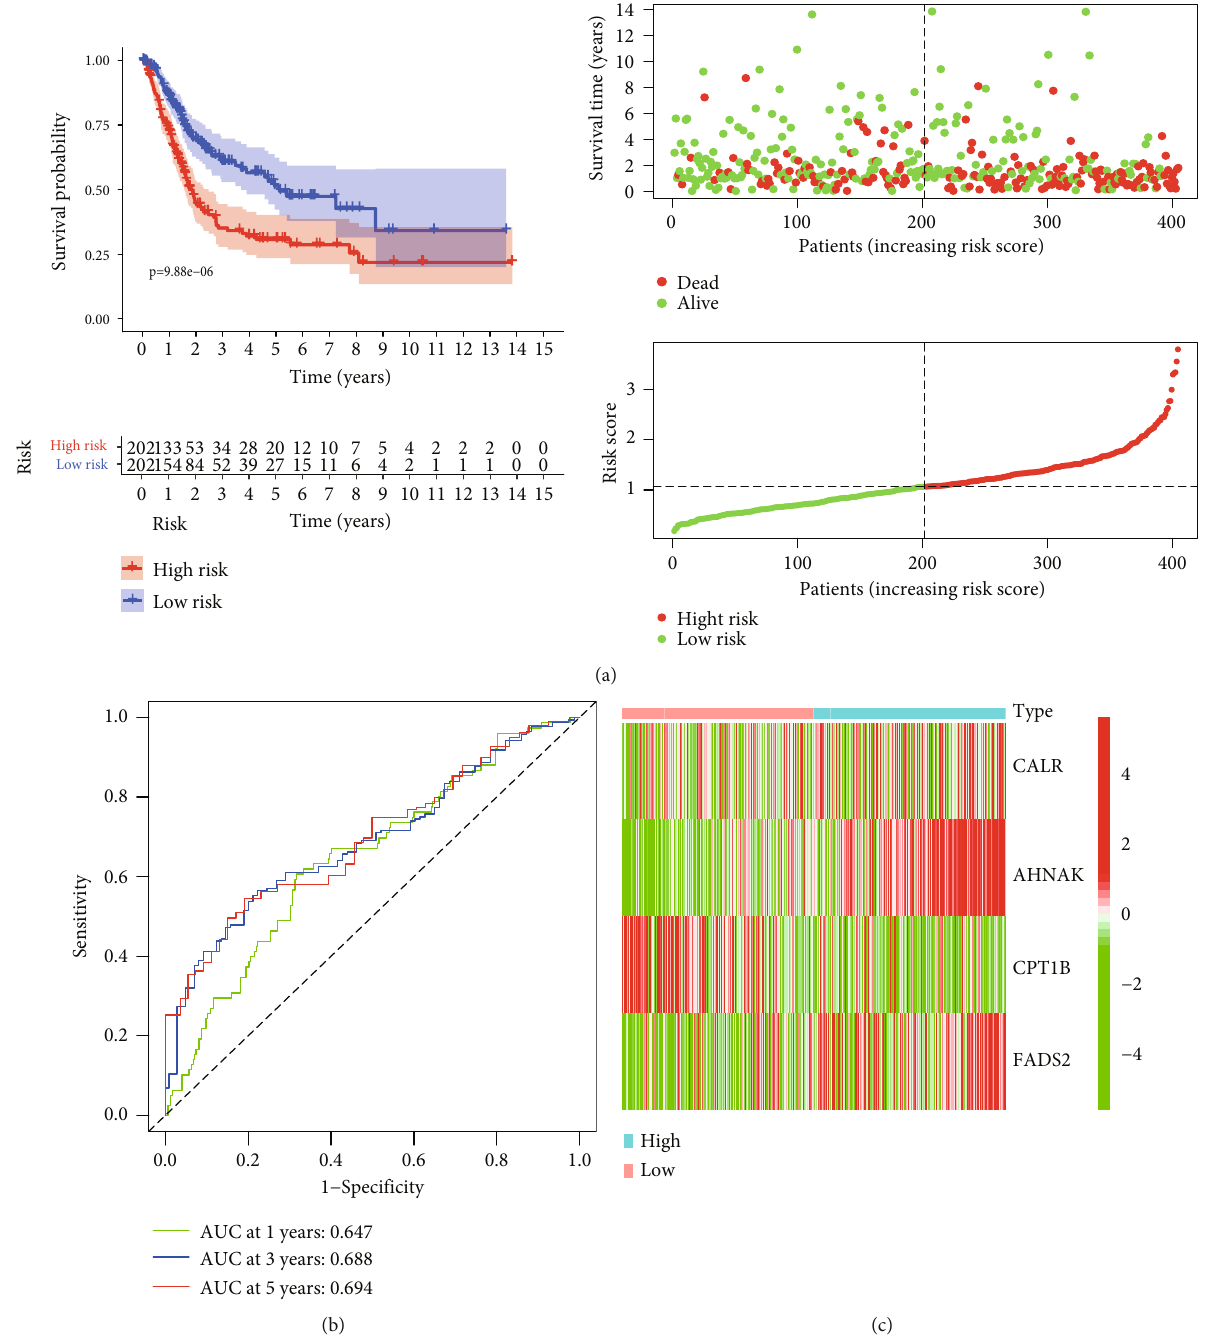
Figure 4: Construction of the PPAR signature correlated with prognosis in the TCGA dataset. (a) Kaplan-Meier curve showed that low-risk patients had better survival compared with the high-risk patients. The distribution of overall survival between the high-risk group and the low-risk group. The distribution of PPARscore between the high-risk group and the low-risk group; (b) time-independent receiver operating characteristic (ROC) analysis for evaluating the predictive performance of PPARscore; (c) heatmap showed the expression patterns of 4 genes between the high- and low-risk